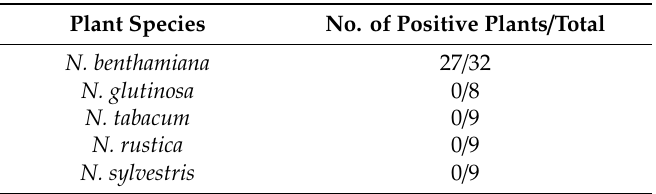
Table 2. RT-PCR detection of FLRaV in five di ff erent plant species mechanically inoculated with sap form symptomatic